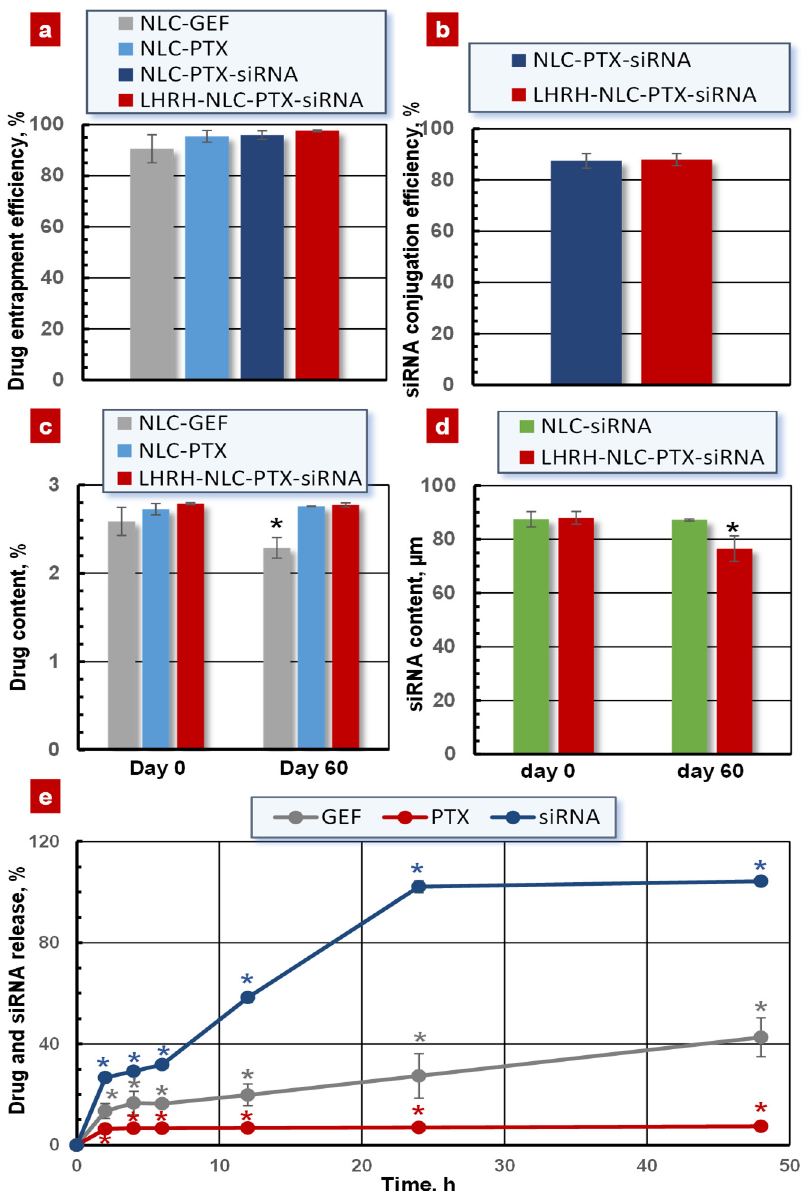
Figure 6. Drug/siRNA loading and release for different nanoparticles. ( a ) Entrapment efficiency of GEF and PTX; ( b ) Conjugation efficiency of siRNA; ( c ) Drug content during the storage in aqueous solution under physiological pH at 4 °C; ( d ) siRNA content during the storage in aqueous solution under physiological pH at 4 °C; ( e ) Drug release in aqueous solution under physiological pH and 37 °C. Means ± SD are shown. * p < 0.05 when compared with day 0.